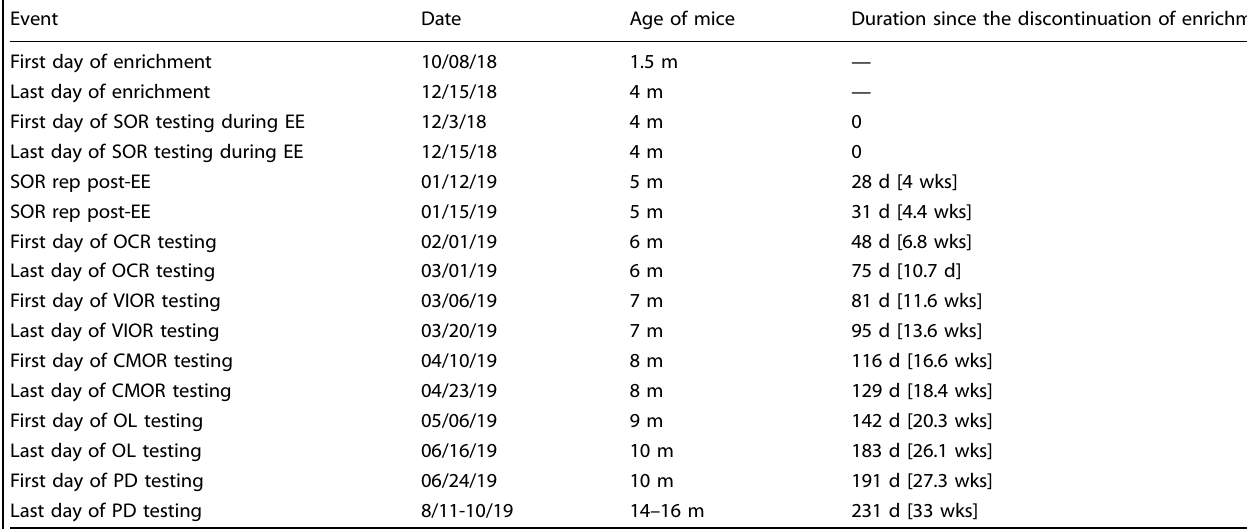
Table outlining enrichment and behavioral testing schedule, including experiment date, age of mice during each experiment, and duration between enrichment discontinuation and behavioral testing. rep repeated, m months, wks weeks, d